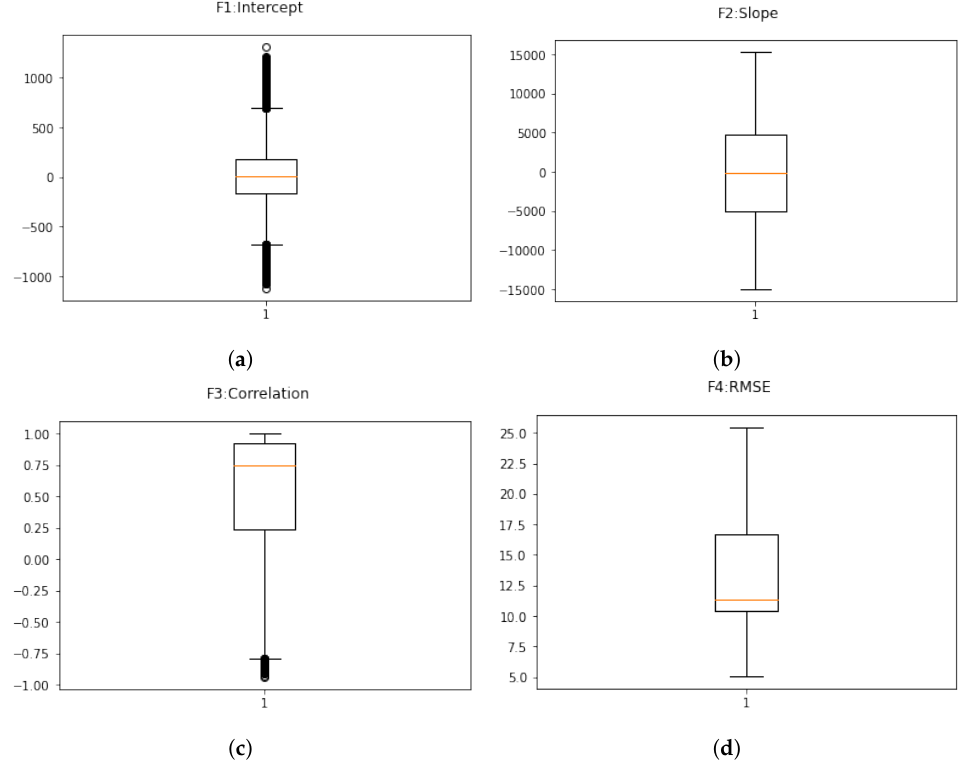
Figure 9. Box plot for each input feature in Dataset-3 (noise level from 10% to 40% and THD level 50%). ( a ) m. ( b ) c. ( c ) R. ( d )